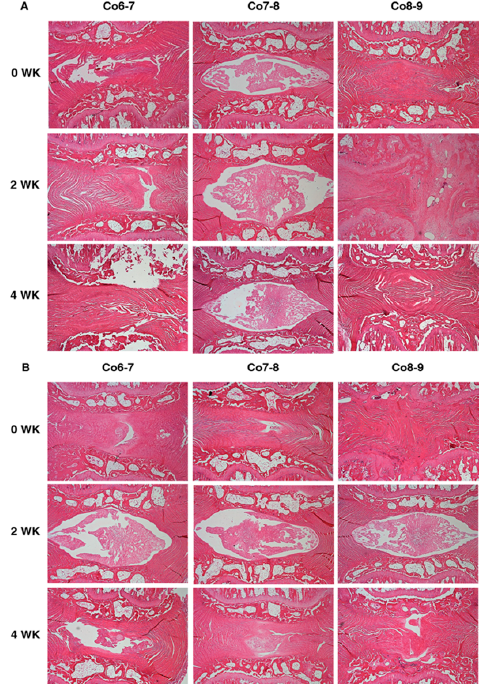
Figure 3. Hematoxylin and eosin staining for comparing the morphological change of injecting (original magnification 40×) ( A ) Baculo-BMP-7-BMDMSCs and ( B ) BMDMSCs only at different treatment time-points (zero, two, and four weeks after puncture). Co7-8 is the control disc with no injection. Co6-7 and Co8-9 are the punctured discs with injection of cells.